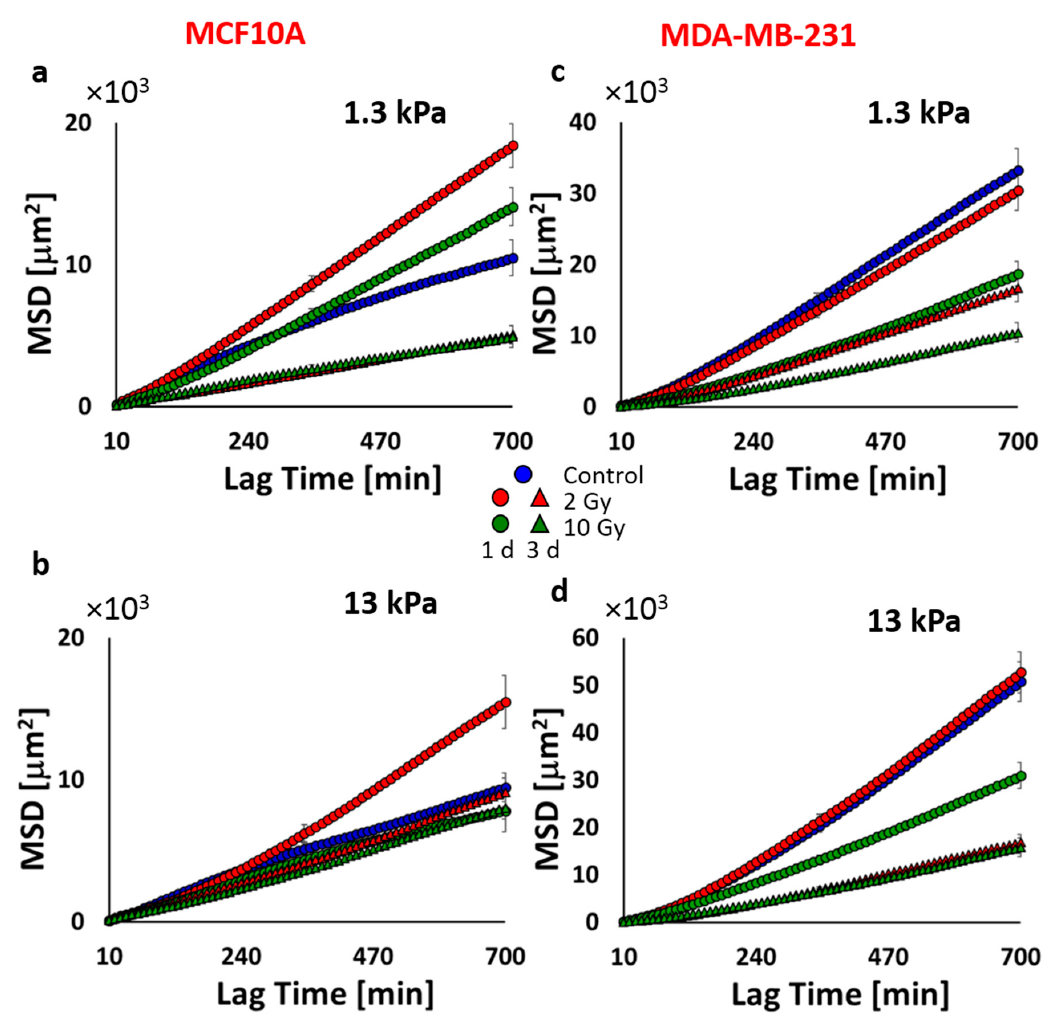
Figure 4. MSDs (mean square displacements) calculated from cell trajectories of MCF10A (a,b)